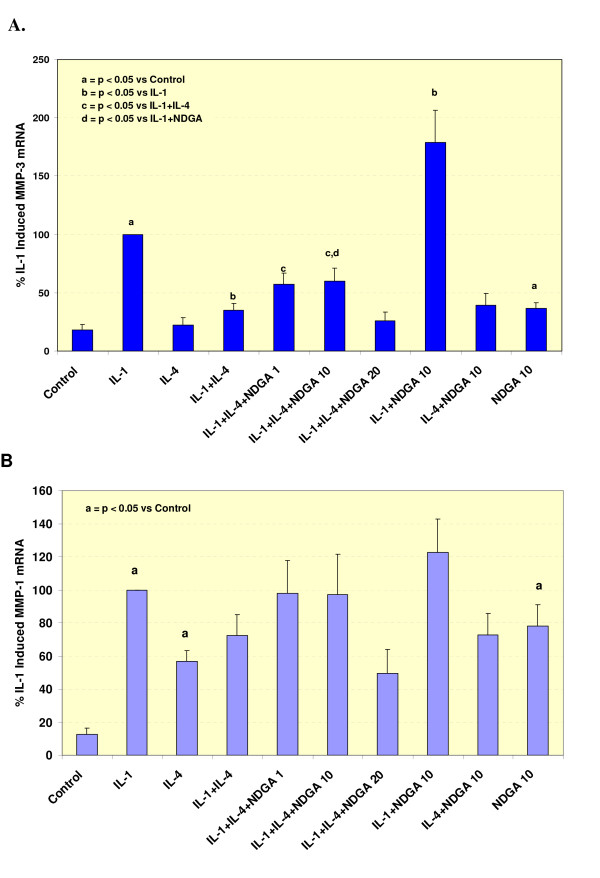
IL-4 suppression of MMP-3 is independent of lipoxygenase activity, but inhibition of lipoxygenase super-induces MMP mRNA. HGF cultures were pre-treated with NDGA at the indicated doses for 1 hour prior to addition of IL-1 (10 ng/ml) and/or IL-4 (10 ng/ml). Total RNA was harvested 12 hours after cytokine treatment, quantitated by real-time PCR and normalized to levels of GAPDH. A) MMP-3. The graph represents data from seven independent experiments performed in triplicate, expressed as mean +/- SEM. B) MMP-1. The graph represents five independent experiments performed in triplicate, expressed as mean +/- SEM. Statistical significance was determined using Student's t-test.